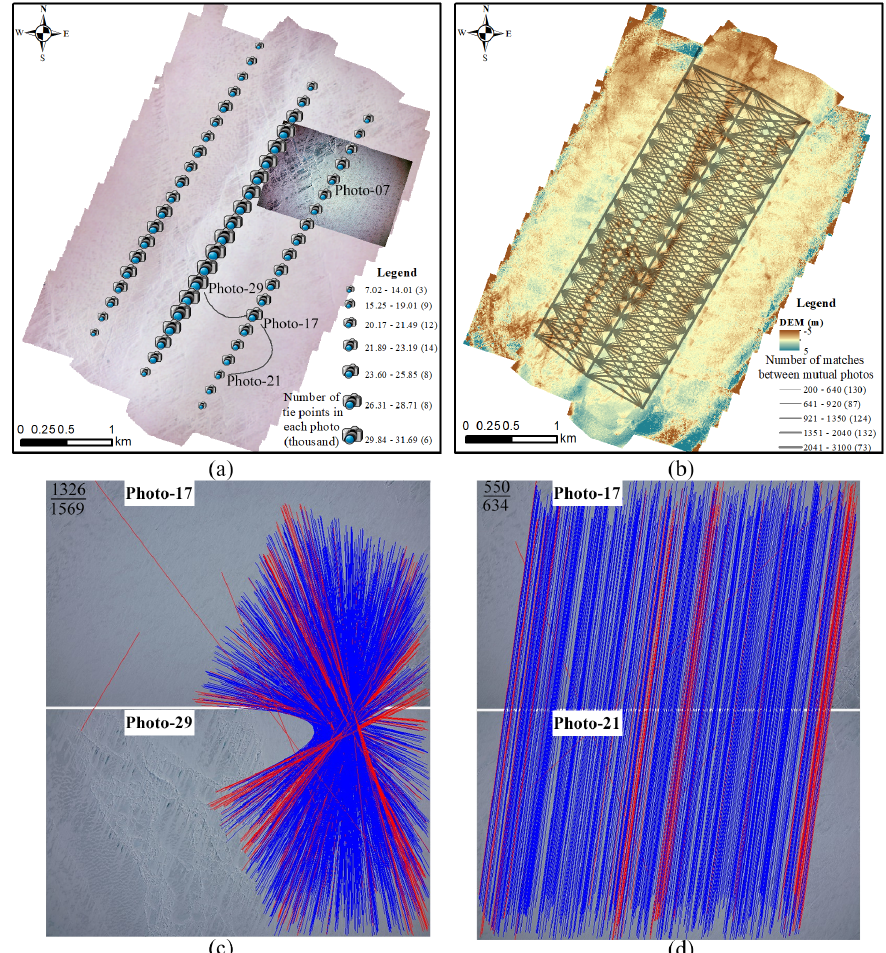
Figure 5. The matching results after alignment optimization. Sortie-3 is shown here, as the example: ( a ) The coordinates of each exposure station, with the size of the camera representing the amount of tie-points in each photo. The number after each item in the legend denotes the counts falling into the corresponding category. The geo-rectified photo-07, whose discernible ’vignetting effect’ cannot be neglected in image stitching, is overlaid on top of the orthomosaic. Two curves link photo-29 and photo-21 with photo-17, whose matching performances are shown in panels ( c ) and ( d ); ( b ) Alignment performance between each possible pair link among all 60 input photos, with the line thickness representing the amount of successful tie-points matches; ( c ) Matching result between photo-17 and photo-29, as an example of sideways-neighbouring areas. A total of 1326 out of the 1569 feature points were tied properly (blue links). The matching links are reversed due to the 180 ◦ difference of heading between adjacent courses. Red links denote local erroneous matches, which may severely deviate from the holistic pattern, which is dealt with in later camera orientation and sparse point cloud generation. ( d ) Matching result between photo-17 and photo-21, as an example of forward-neighbouring areas. A total of 550 out of the 634 feature points were tied properly. The nearest two neighbours were not selected here for visually clear purposes, since tie-point links are too dense to represent. The same symbology as in ( c ) is